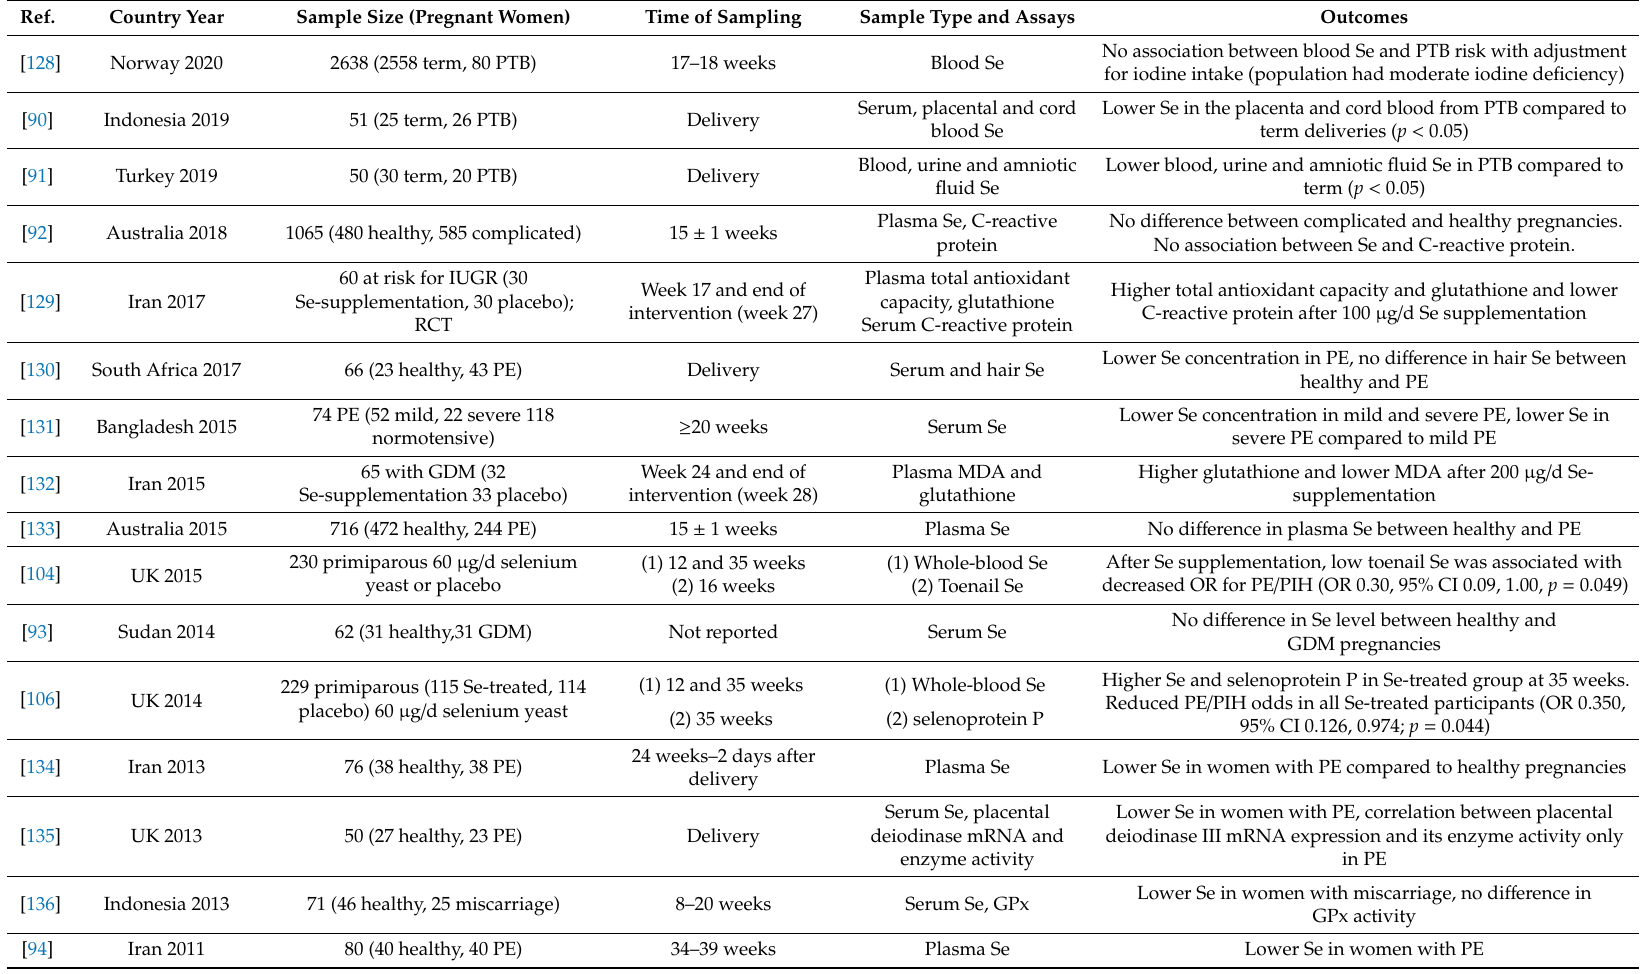
Table 2. Association between maternal selenium levels or selenoproteins and pregnancy